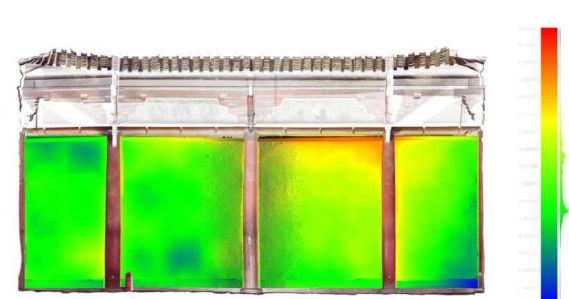
Figure 1923 the Main Hall west wall shape changes for the four section mural